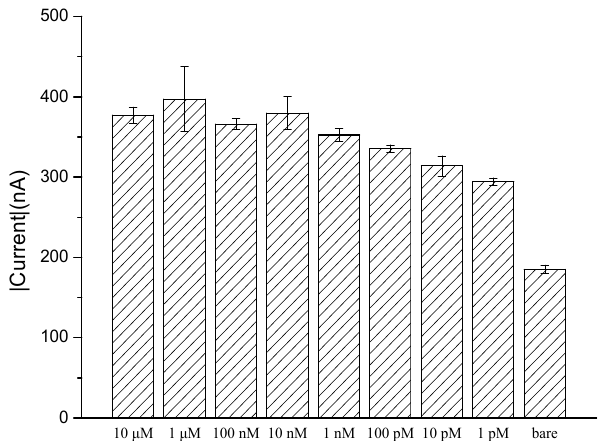
Figure 4. Corresponding current levels to miR-21 concentration using chronoamperometry.